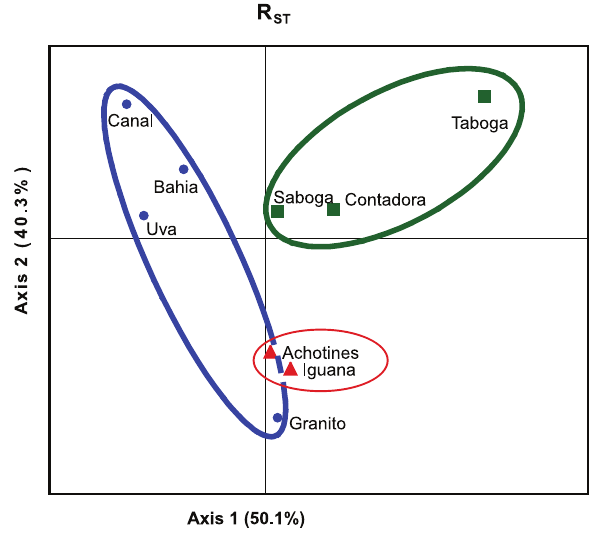
Figure 2. Principal component analysis of Pocilloporadamicornis populations, constructed using GenAlEx 6.1 [ 130 ] . Distances between populations were analyzed as RST pairwise genetic distances. The two axes explained 90.4% of the total variation. Blue circles = Populations in the Gulf of Chiriqui; Red triangles = Azuero Peninsula; Green squares = Gulf of